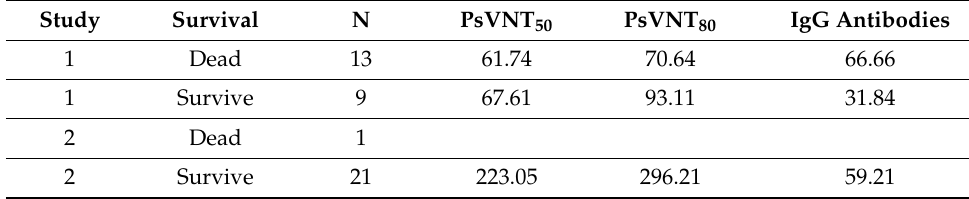
Table 4. Geometric percent coefficients of